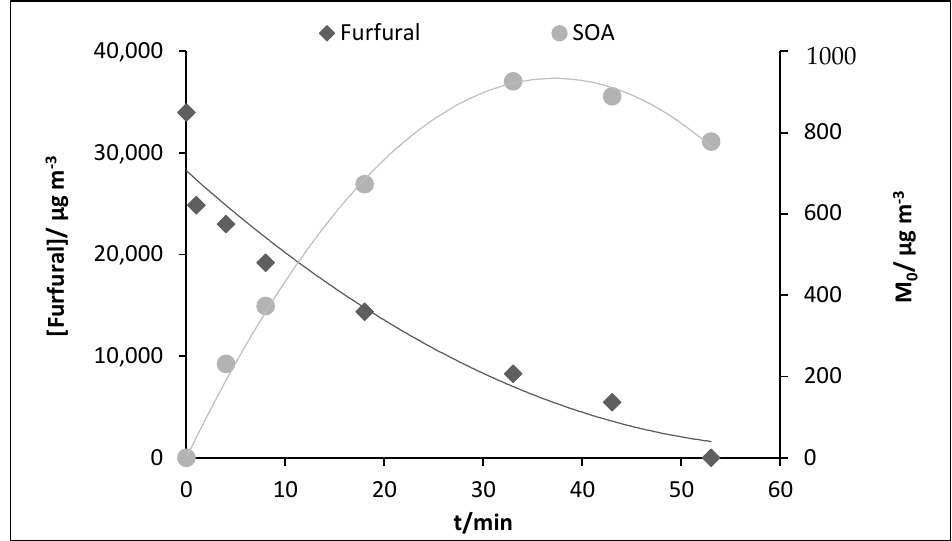
Figure 4. Profile of furfural and aerosol mass under chlorine degradation